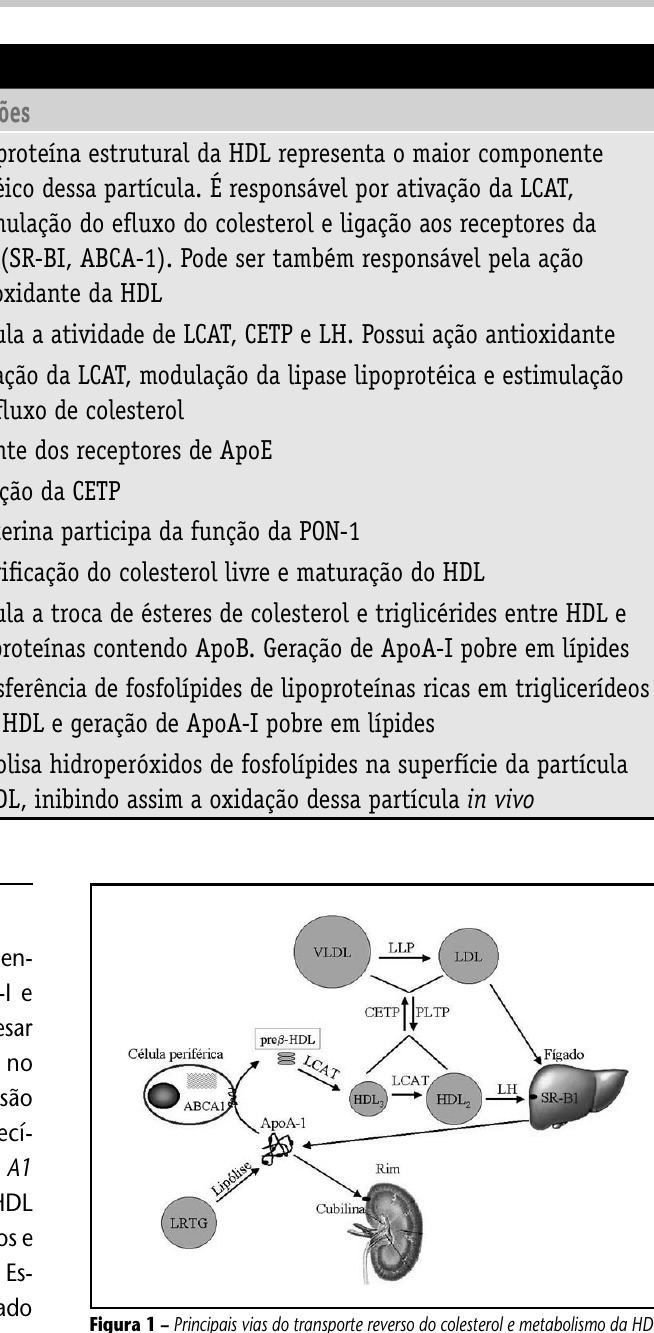
partícula intacta (2) . Por exemplo, os ésteres de colesterol são transferidos para as VLDL e LDL, por ação da CETP, ou